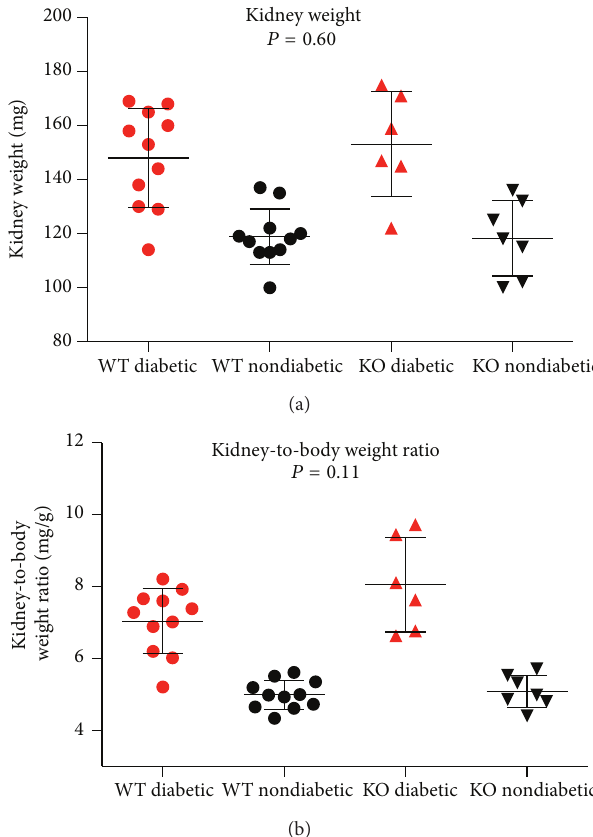
Figure 2: Kidney weight (a) and kidney weight per body weight (b) depicted for each of the four groups. The black error bars are illustrating mean ± standard deviation for each group. WT: wild- type; KO: ficolin B